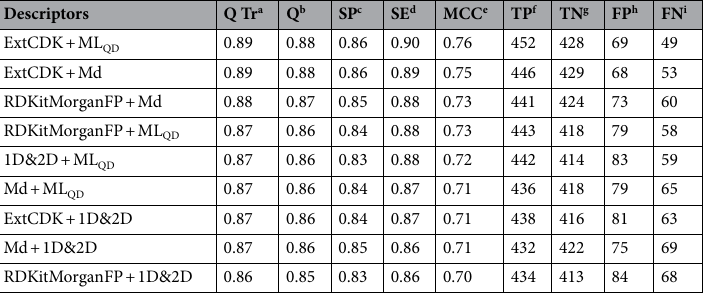
Table 4. Evaluation of the performance of combined descriptors for the prediction of UV–Vis spectrum class using the RF algorithm. a Overall predictive accuracy for the training set in OOB estimation. b Overall predictive accuracy (test set I). c Specificity (test set I). d Sensitivity (test set I). e MCC, Matthews correlation coefficient (test set I). f True Positives (test set I). g True Negatives (test set I). h False Positives (test set I). i False Negatives (test set I).